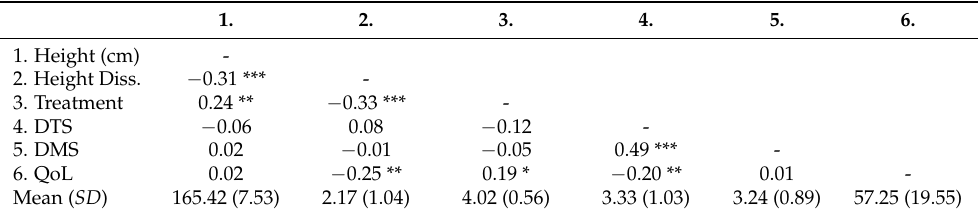
Table 1. Correlations, means, and standard deviations of height, height dissatisfaction, treatment due to height score, drive for thinness, drive for muscularity, and quality of life.